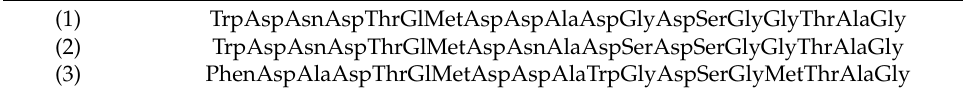
Table A2. Amino Acid Sequences of Peptides Produced by Selected